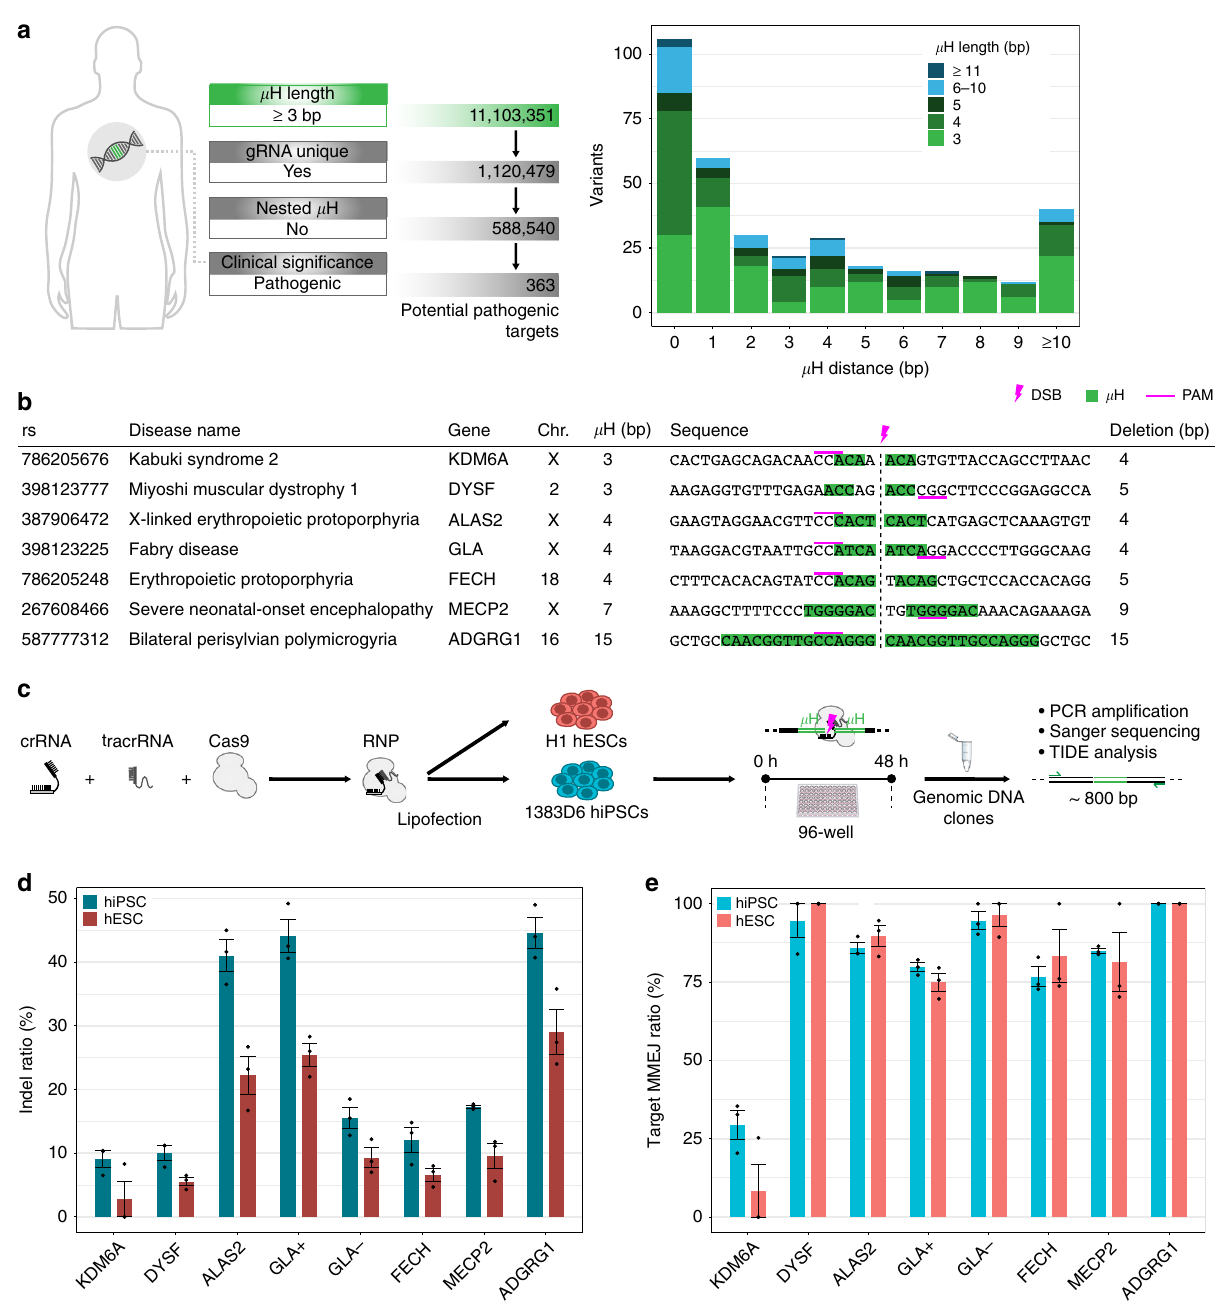
Fig. 2 Selected pathogenic target µ H- fl anked deletion mutations can be recreated with high precision in hiPSCs and hESCs. a Filtered MHcut tool output of potential target pathogenic variants for the parameters shown. Graph at the right shows the distribution of target variants by µ H distance with µ H length indicated by fi ll color. b Selected target variant list. µ H (green), DSB location (pink bolt), SpCas9 PAM (underline). c Schematic of the experimental method used to create MMEJ deletion alleles in 1383D6 hiPSCs and H1 hESCs. d Overall ratio of indel mutations found in the transfected hiPSC or hESC